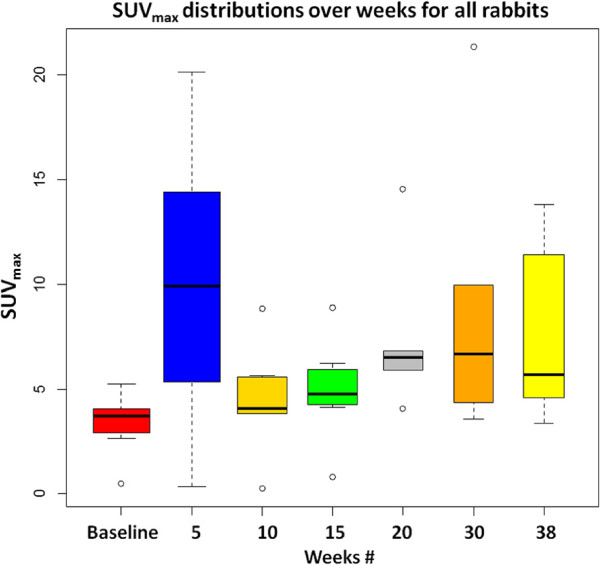
SUVmax distributions for all rabbits are shown over weeks.